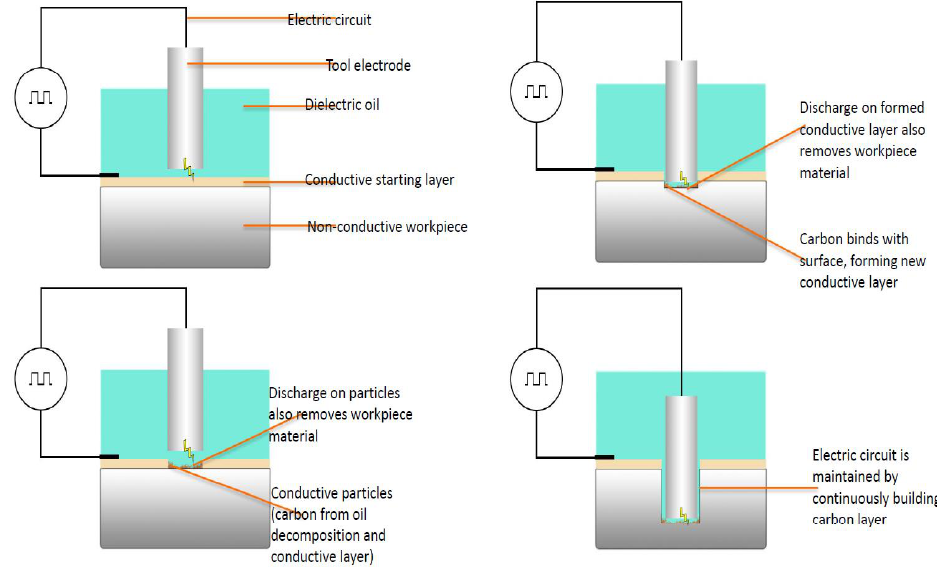
Figure 17. Assisting electrode scheme for machining nonconductive ceramic materials [154].